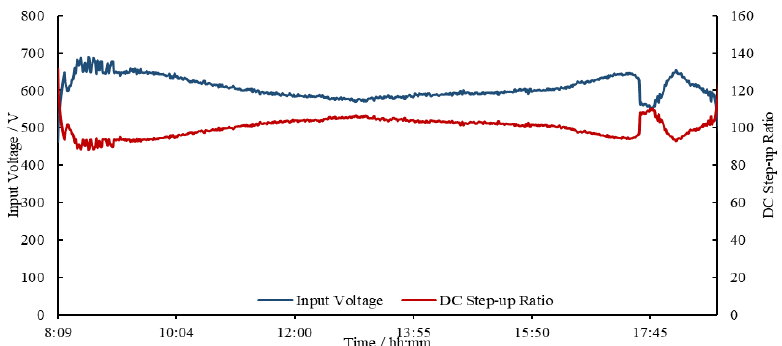
Figure 33. Input voltage and DC step-up ratio of the DC/DC converter on a sunny day.